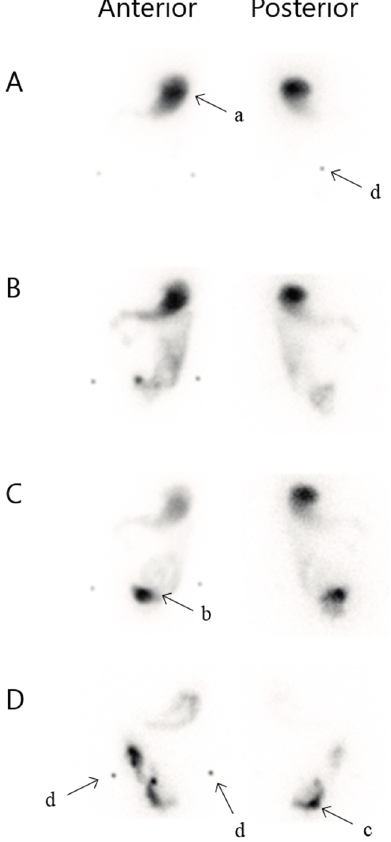
Figure 1. Scintigraphic small intestinal transit time. Anterior and posterior